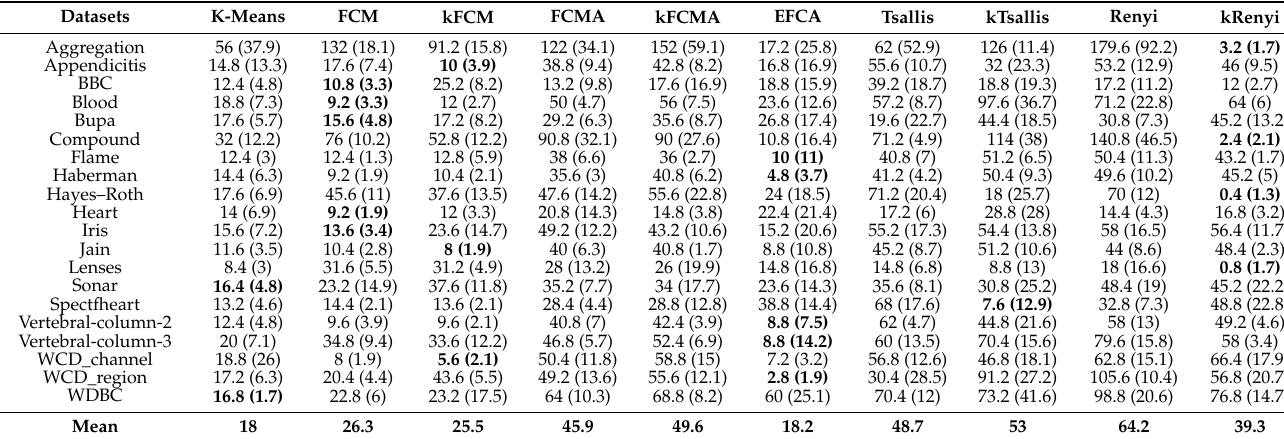
Table 8. Computational cost of the different methods on the benchmark datasets. Table cells present the mean time in milliseconds (ms) expended by each method on each dataset with the parametric configuration returned by the DE algorithm for the 10 replications. In brackets are the standard deviations obtained for the 10 experimental replications. The lowest mean cost for each dataset is highlighted in